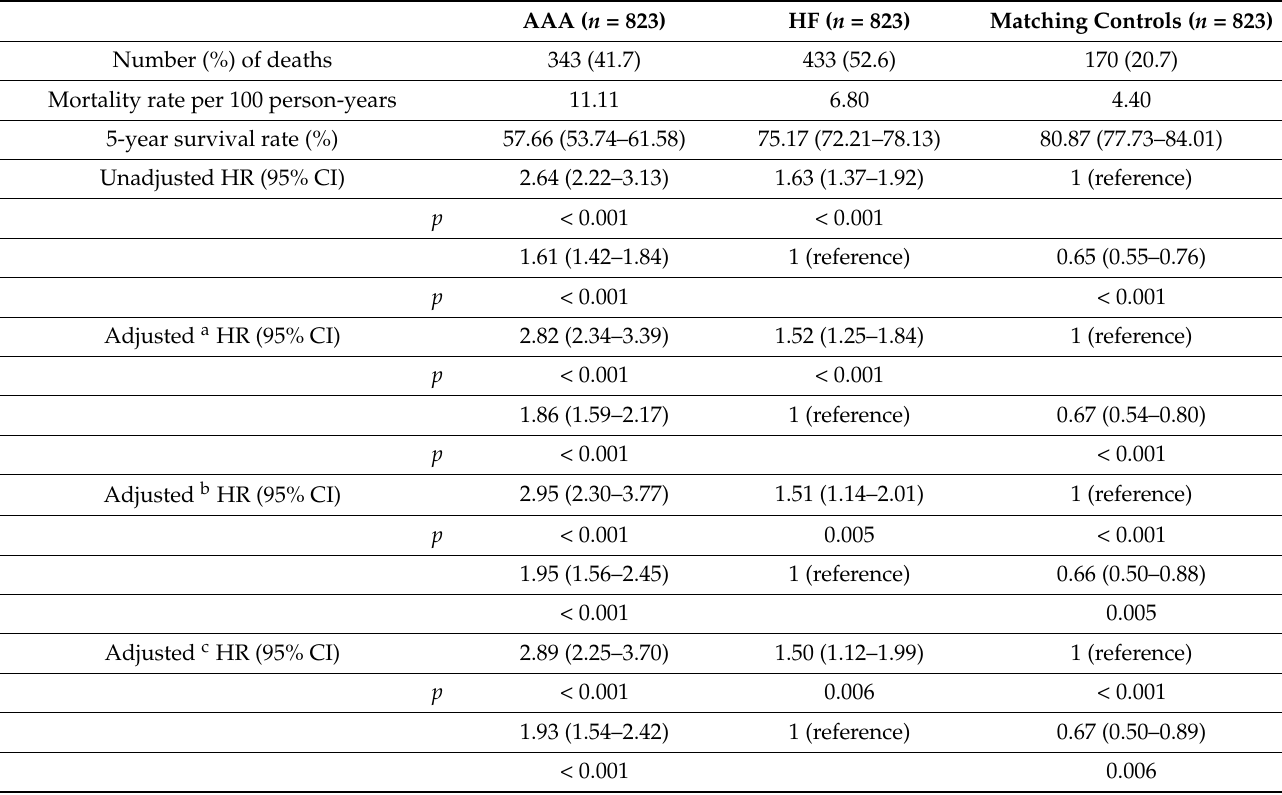
Table 5. Comparison of the mortality rate .